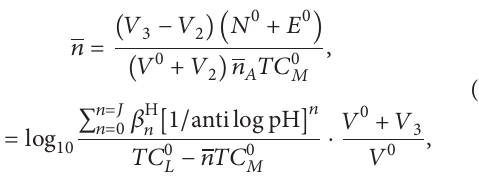
) in 10 (by volume) ethanol-water mixtures and 0.1mol 1 %